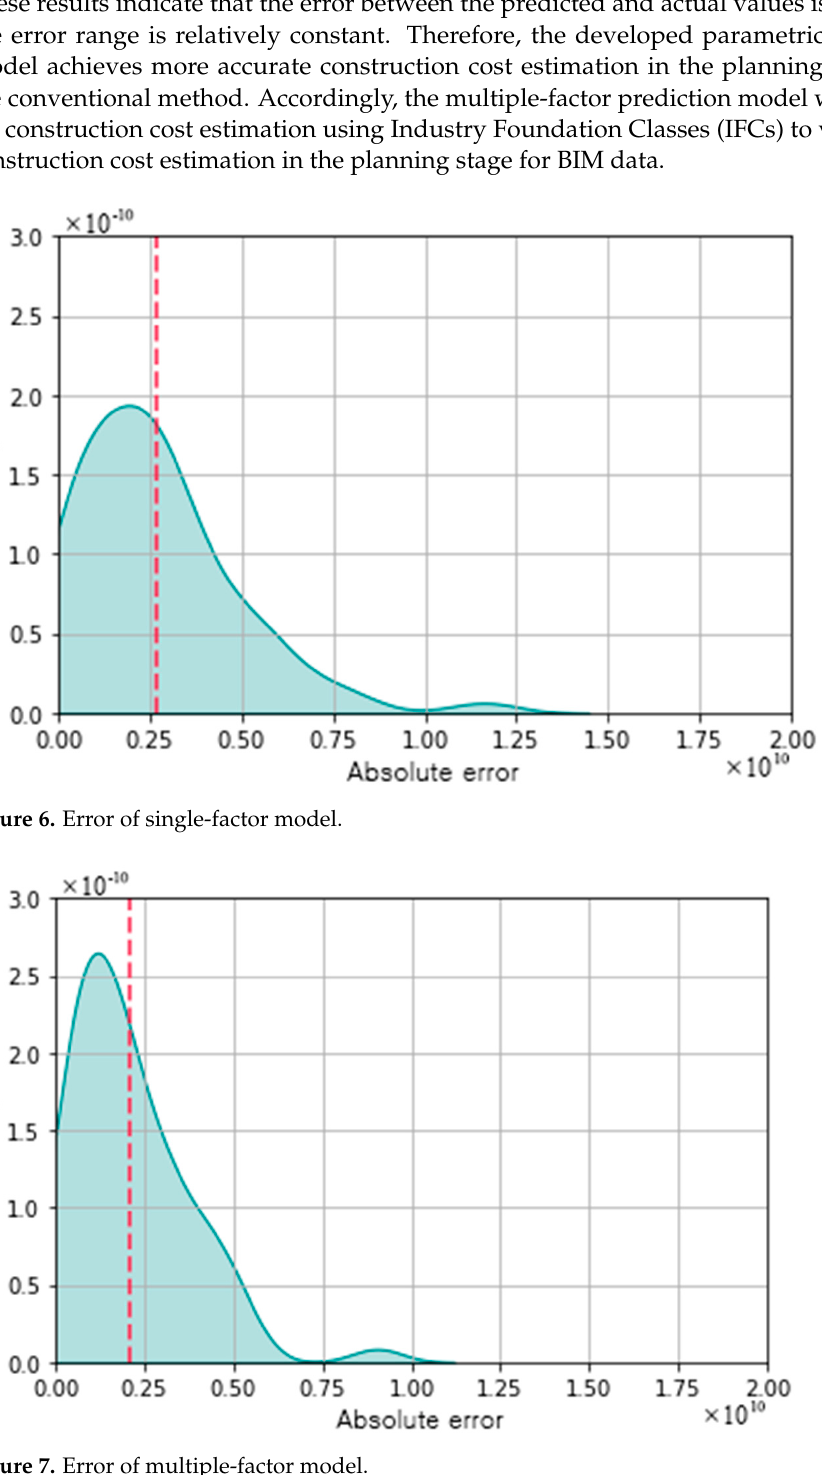
Figure 7. Error of multiple-factor model.